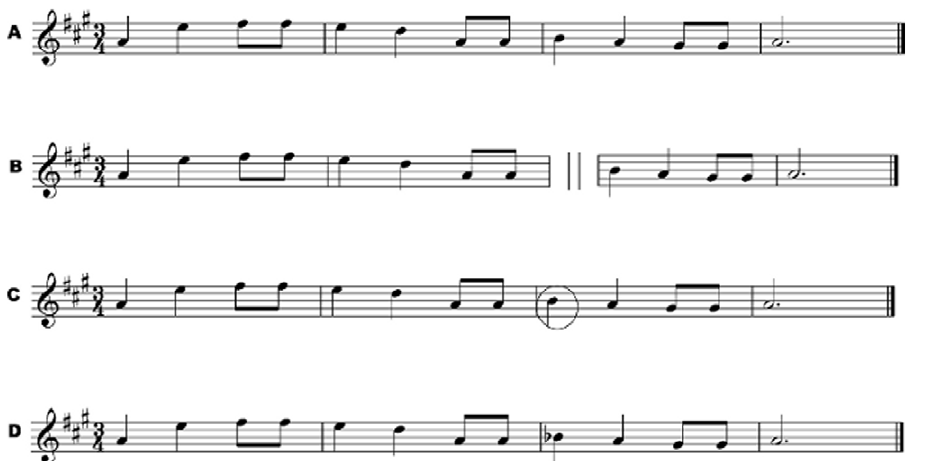
Figure 1. Example of a melody in the On-Line Identification Test of Congenital Amusia. Conditions for the melody are shown: no incongruity (A), time incongruity (B: I refers to the silence of 5/7 of the beat duration), mistuned pitch incongruity (C: the circled note refers to the mistuned pitch), and out-of-key pitch incongruity (D).